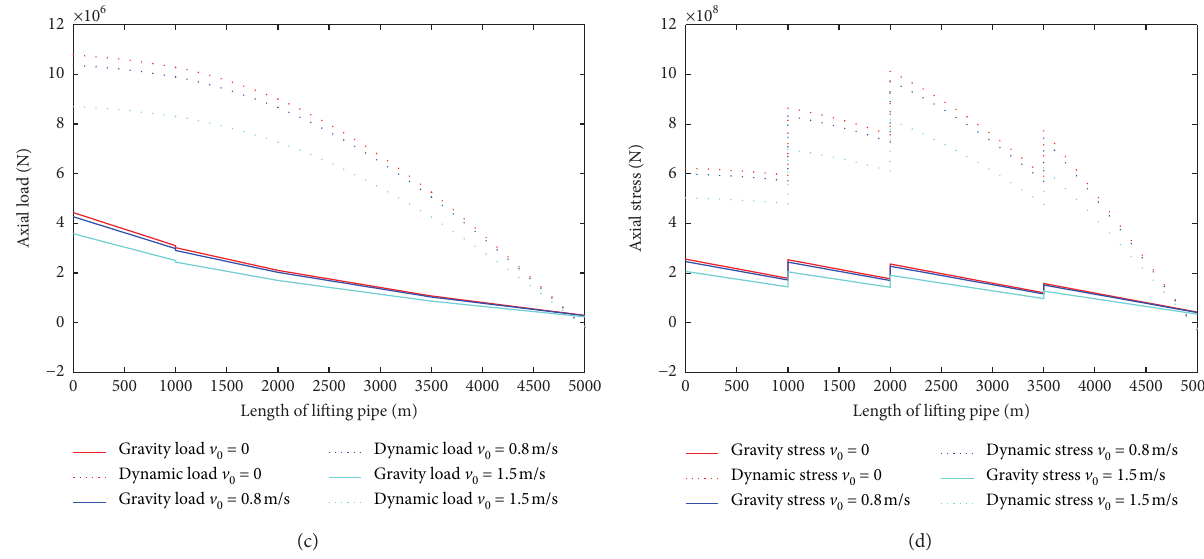
Figure 10: Axial load and stress of the lifting pipe. (a) Influence of buffer mass on axial load. (b) Influence of buffer mass on axial stress. (c) Influence of sailing velocity on axial load. (d) Influence of sailing velocity on axial